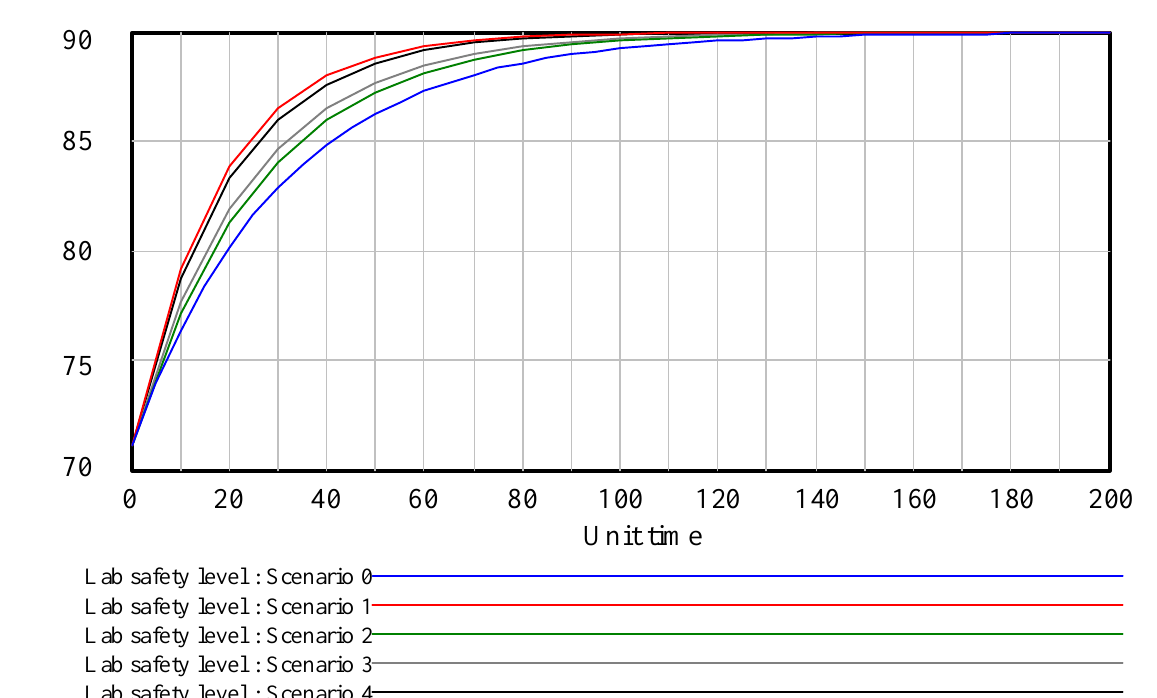
Figure 8. Laboratory safety level with different safety input increase rates.